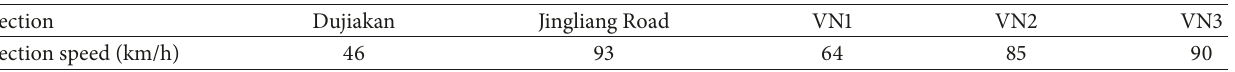
Table 3: The section speed at the virtual node and the toll